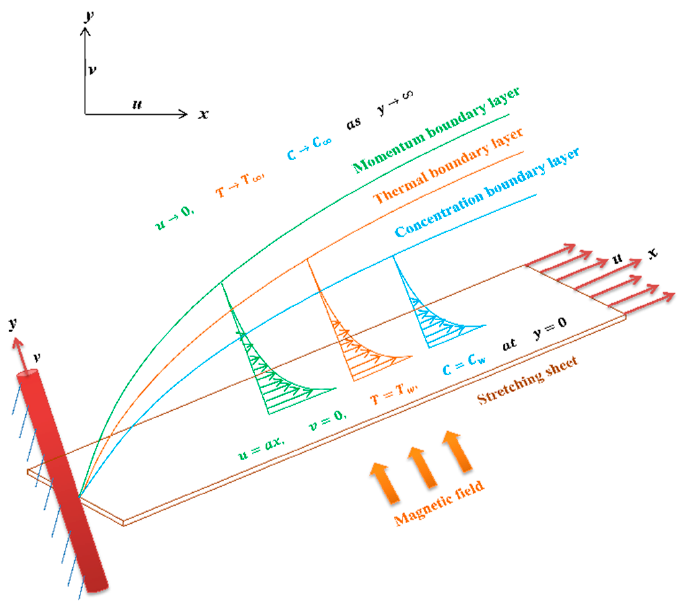
Figure 1. Analyzed geometry with boundary conditions and coordinates. Further, a uniform magnetic field B 0 is applied normally to the x -axis. Additionally, due to the influence of equal and opposite forces, the surface is stretched over the flow direction with a fixed origin. However, due to the stretching of the sheet along the x -axis, the fluid flow occurred. Further, it is assumed that the surface of the stretching sheet is maintained at a wall temperature T w and wall concentration C w . Additionally, T w